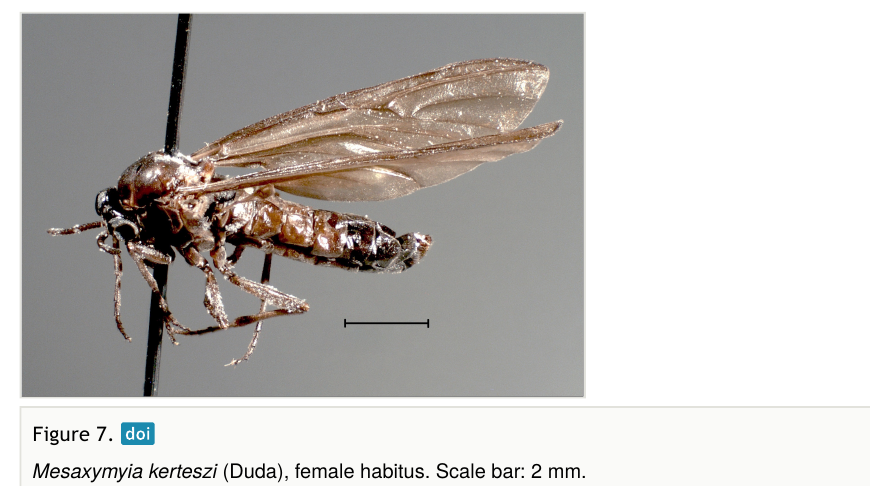
Diagnosis Medium-sized fl ies with darkened wings (Fig. 7).